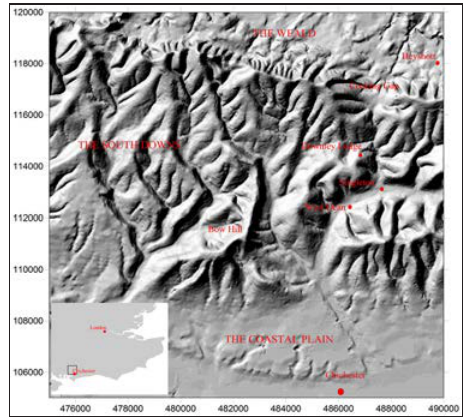
Fig. 1: Digital Terrain Model (DTM) and loca- tion map, showing the relationship of the site to the surrounding geological prov- inces and topography (Contains Ordnance Survey data © Crown copyright and data- base right